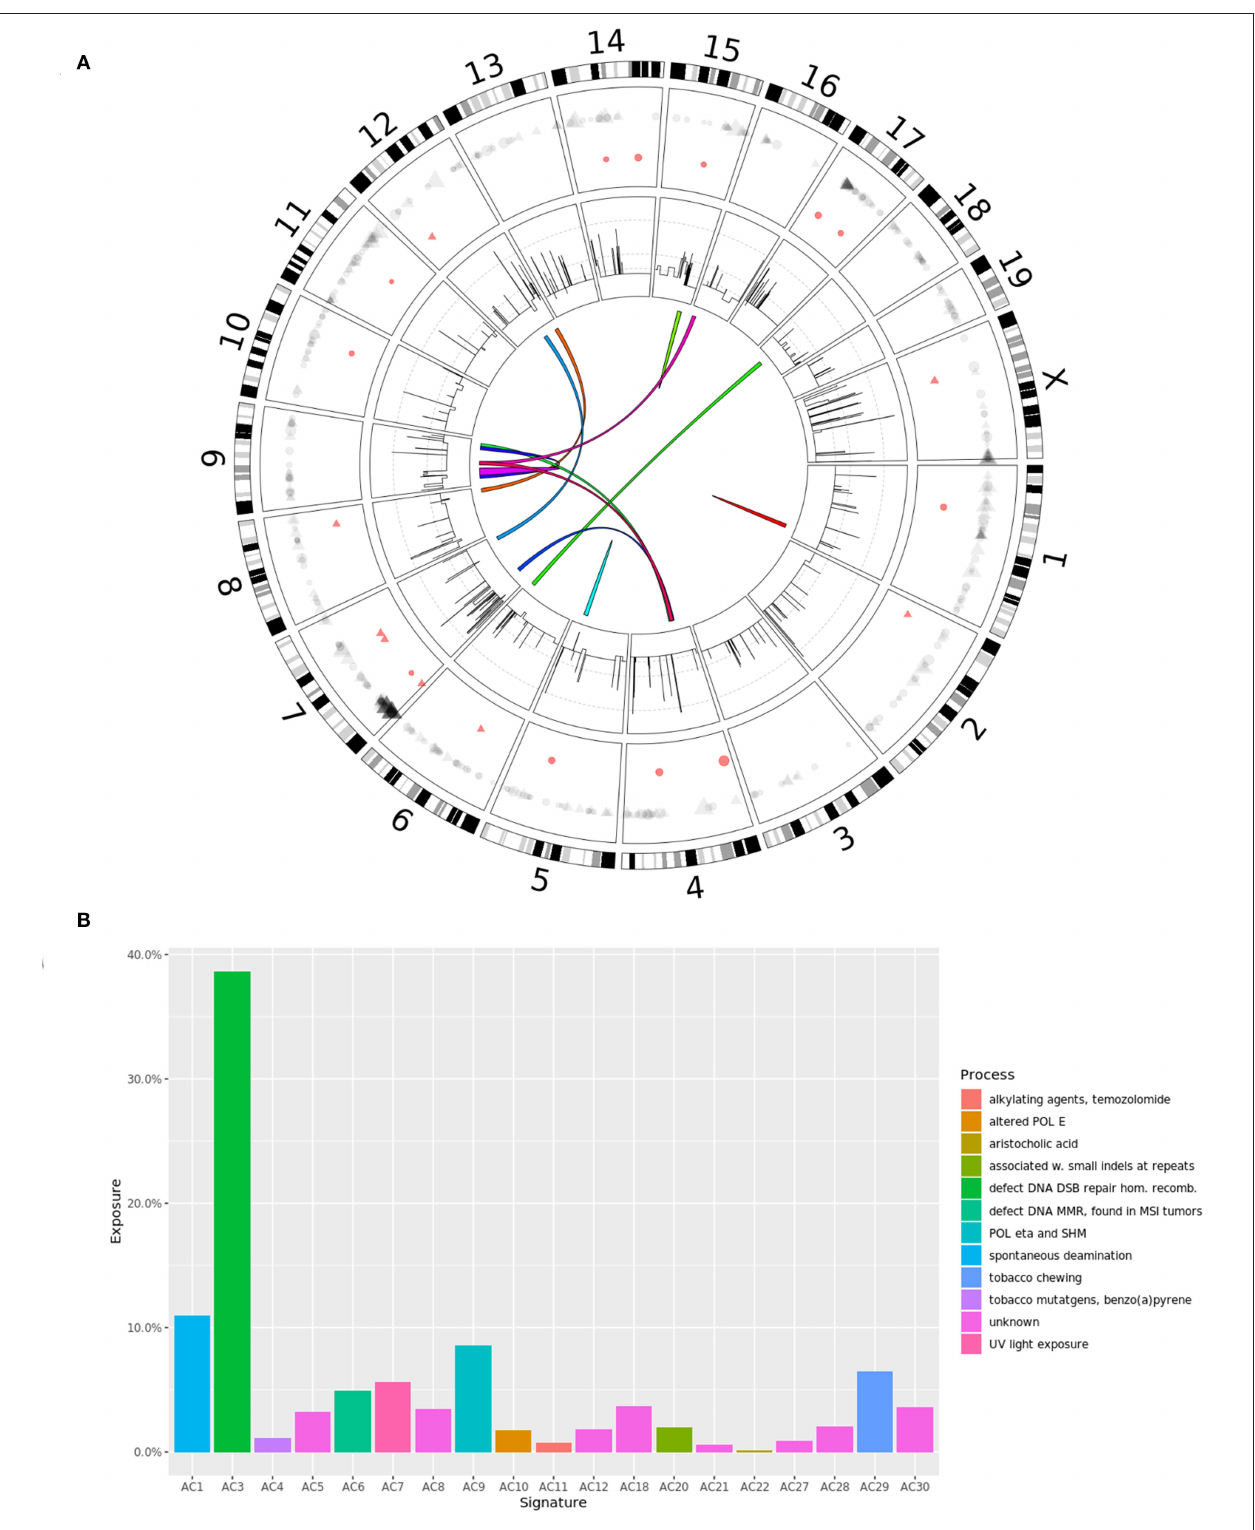
FIGURE 1 | (A) Circos diagram showing the somatic alterations of the 4T1 cell line compared to wild type BALB/c mice: SNVs (outer circle, gray) and small indels (red), with point size scaled by variant allele frequency; CNVs (second circle from the outside), log scaled, with gray lines marking CN = 5, 10, and 50; fusion genes (middle). (B) Mutation signature of 4T1 somatic SNVs. Signatures with a computed exposure value of 0% are not shown.